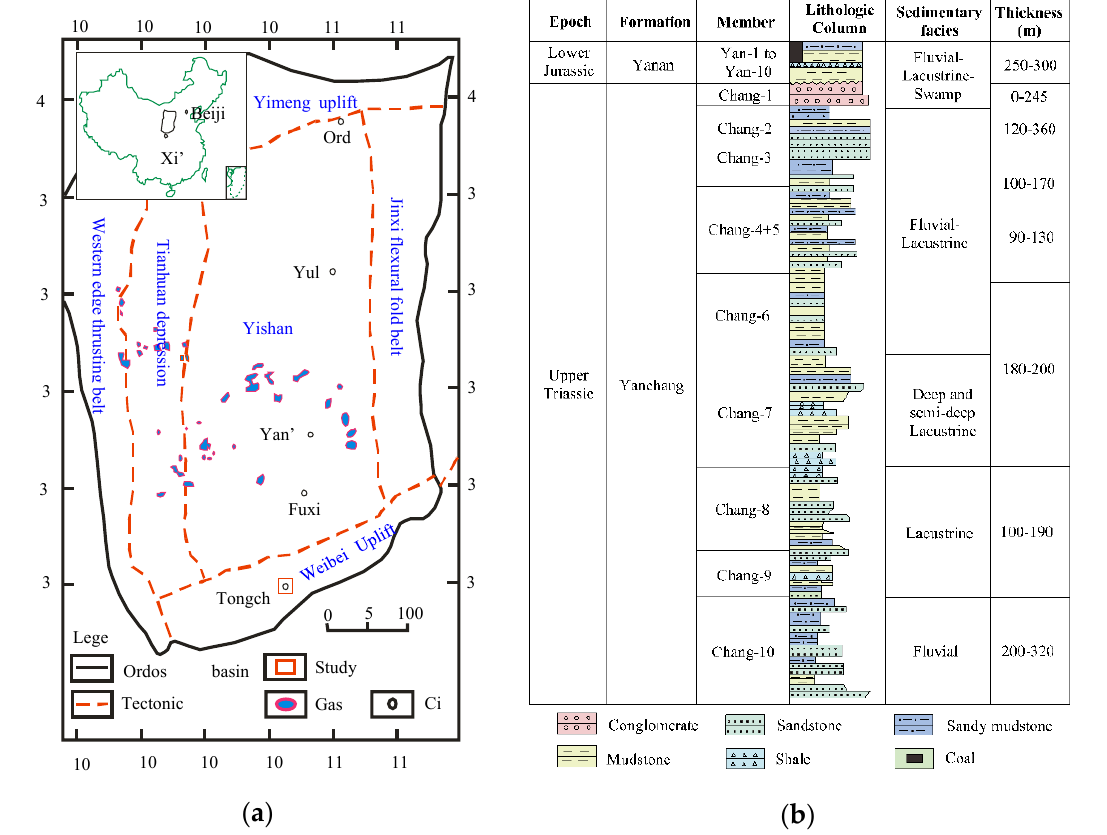
Figure 1. ( a ) Tectonic map of the Ordos Basin [26,27]; ( b ) lithological and electronic characteristics of the Yanchang Formation in the YK01 well [26].